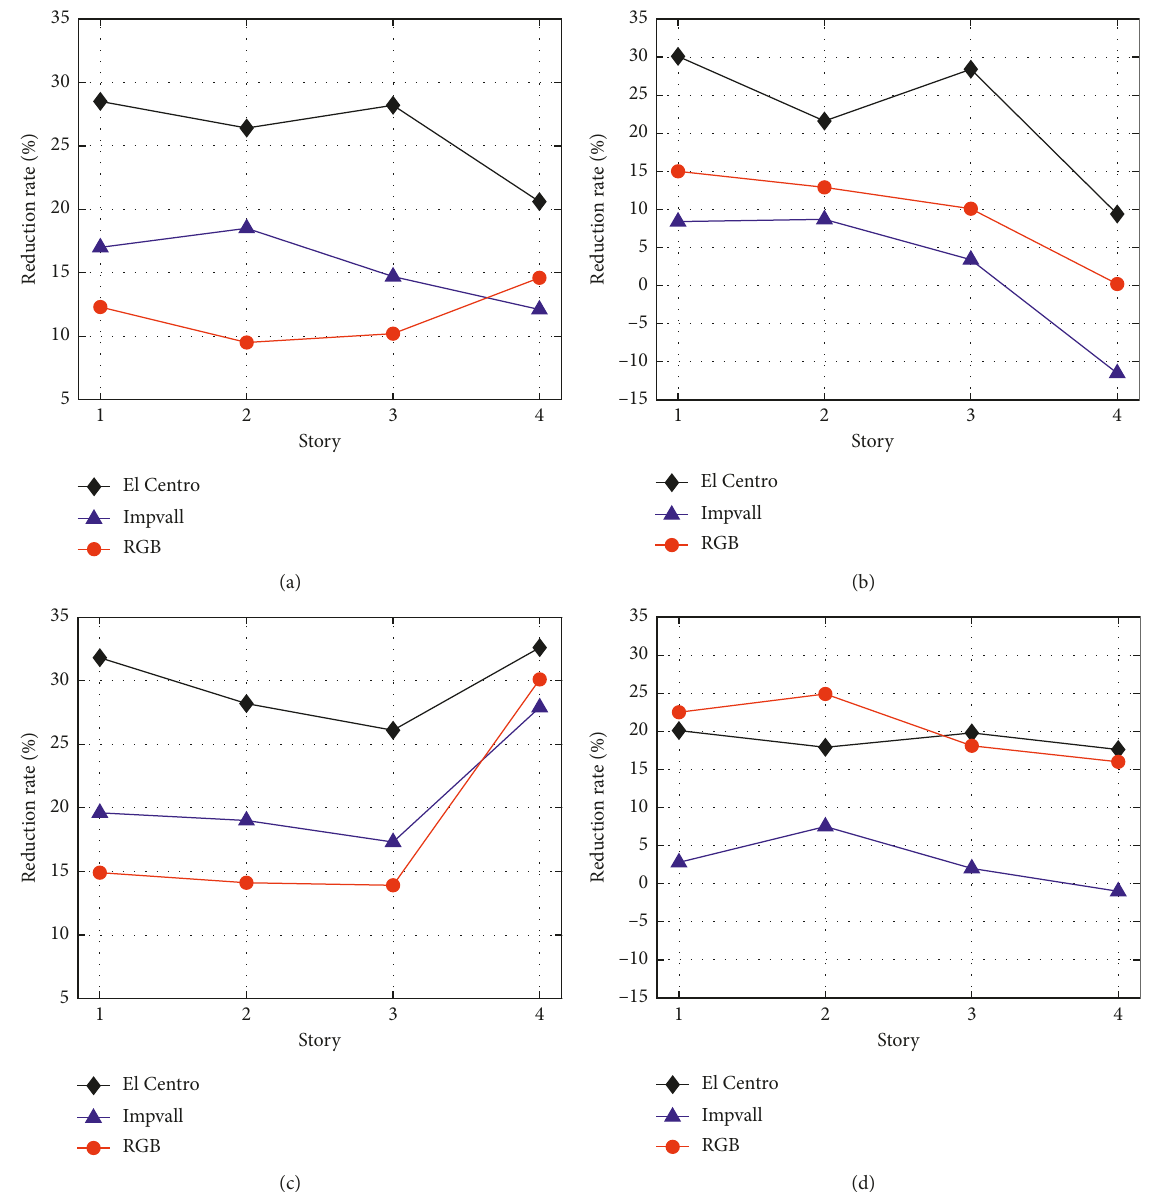
Figure 12: Displacement reduction rates under applied seismic conditions. RMS reduction rate of displacement under (a) frequent- intensity earthquake conditions and (c) moderate-intensity earthquake conditions. Peak reduction rate of displacement under (b) frequent- intensity earthquake conditions and (d) moderate-intensity earthquake